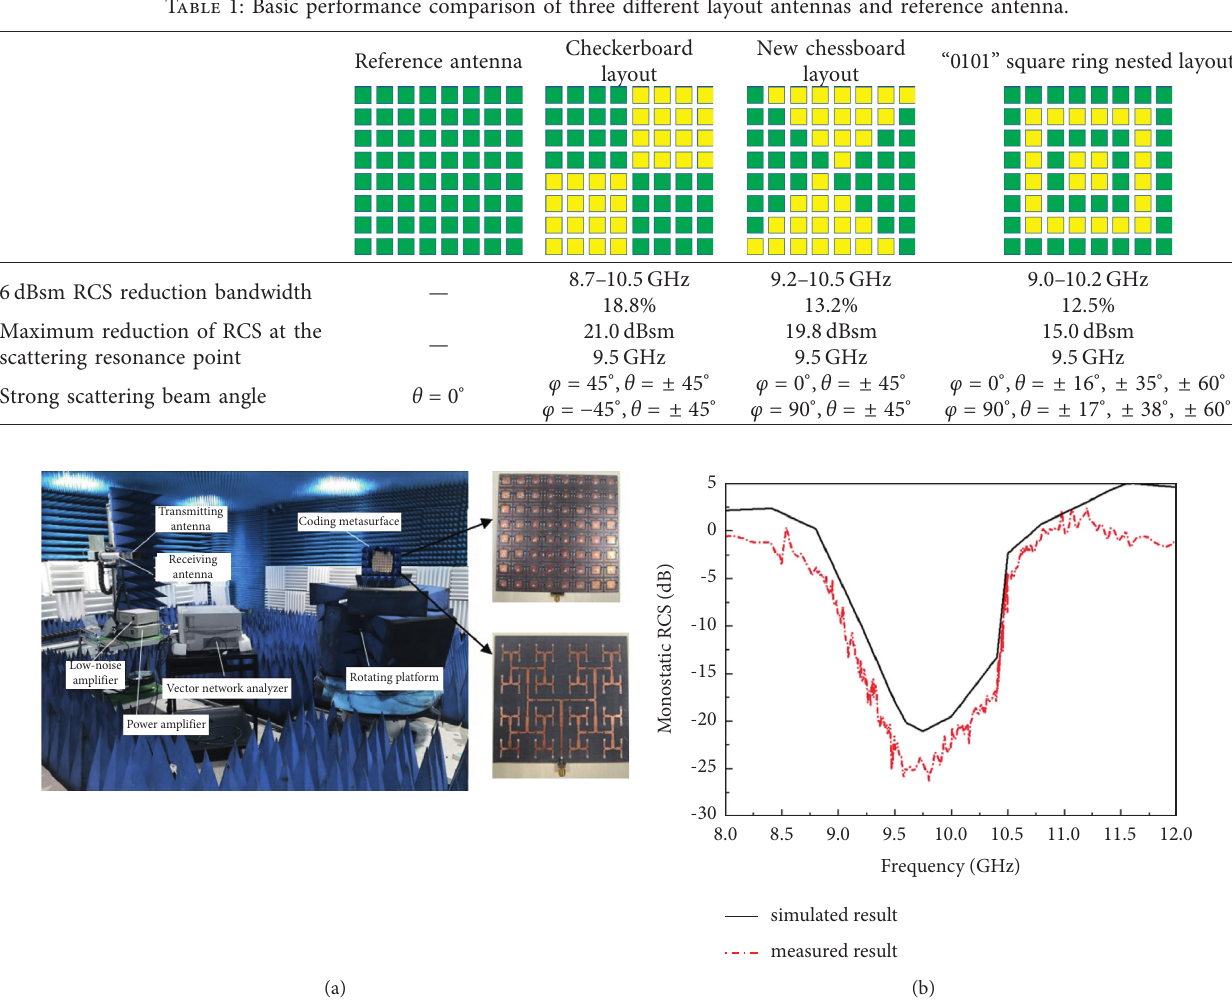
Table 1: Basic performance comparison of three different layout antennas and reference antenna.